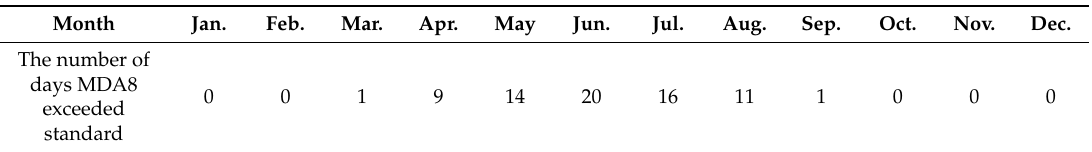
Table 1. The number of days that MDA8 exceeded the standard for each month in 2018 . (Jan.: January,